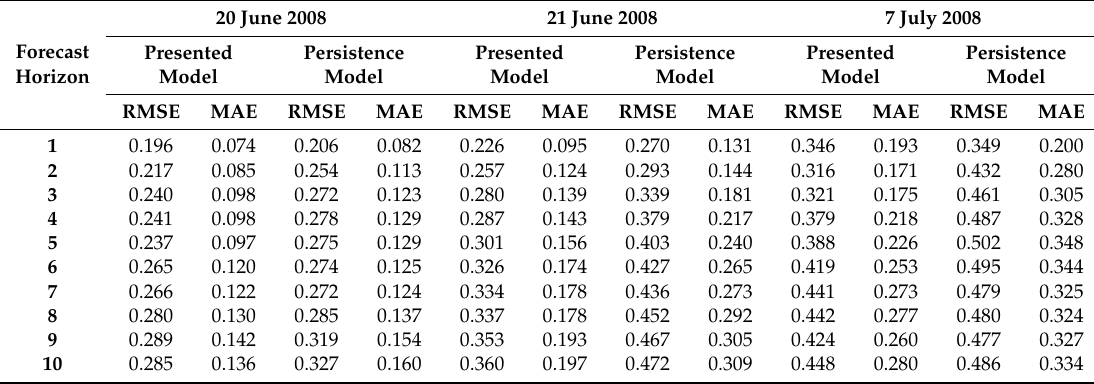
Table 2. RMSE and MAE in W/m2-nm computed for forecasting horizons of 1–10 min.